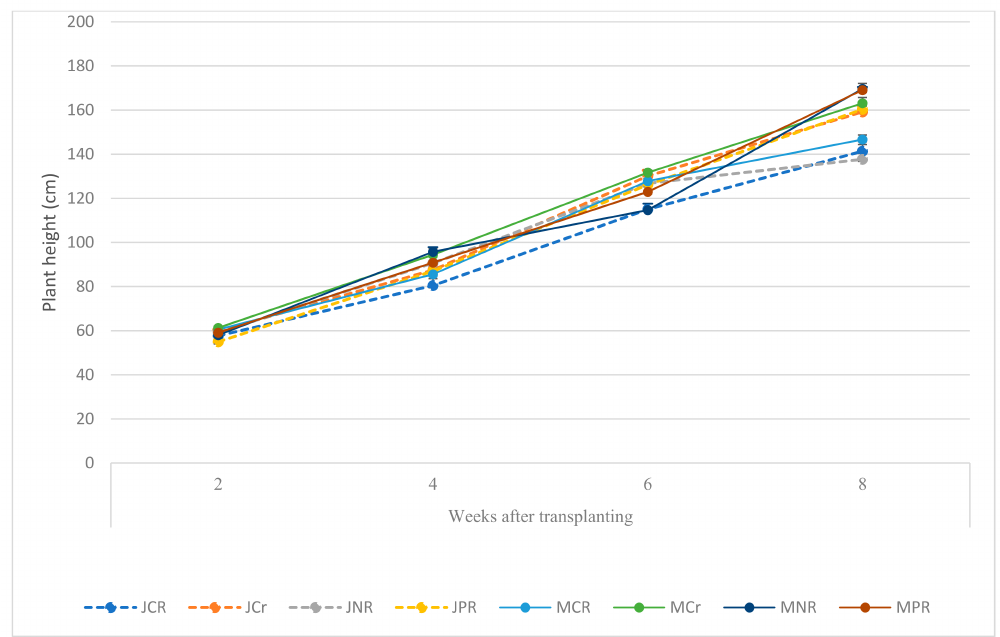
Figure 2. Plant height of tomato cultivars in response to root restriction J, M = Jaguar, Momotaro York cultivars; CR = complete root restriction in 1.0 L pot; Cr = complete root restriction in 1.5 L pot; PR = partial root restriction in Cocowool; NR = no root restriction; Every point represents the mean of three replications ± SE.